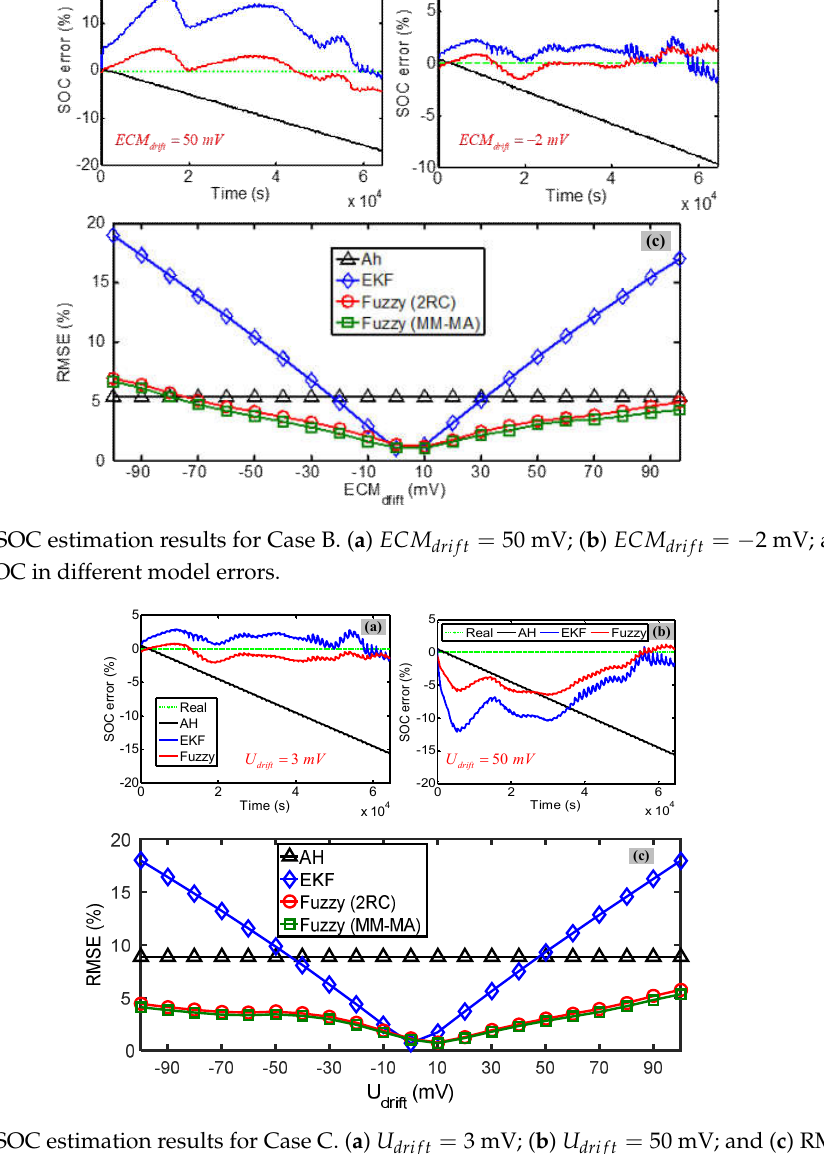
U  ; ( b ) 50 mV U  ; and ( c ) RMSE of drift drift